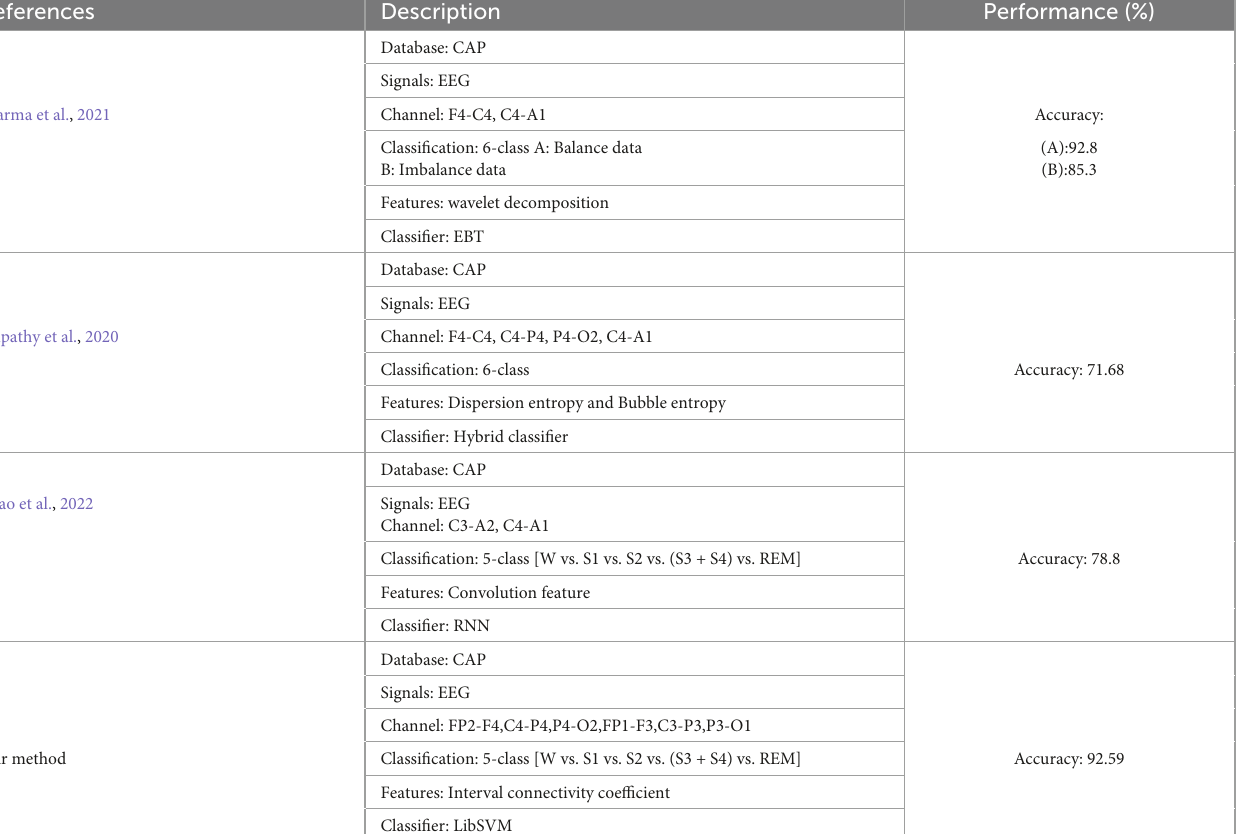
TABLE 7 Comparison of automatic sleep stage classification